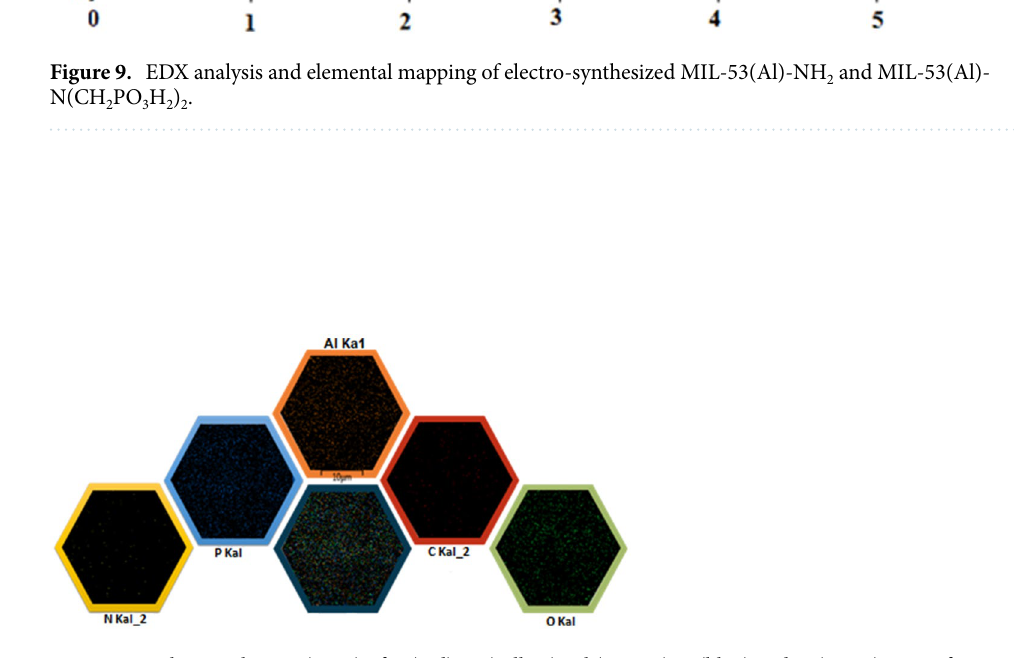
Figure 10. Elemental maps (EDX) of C (red); N (yellow); Al (orange); P (blue) and O (green) atoms for MIL-